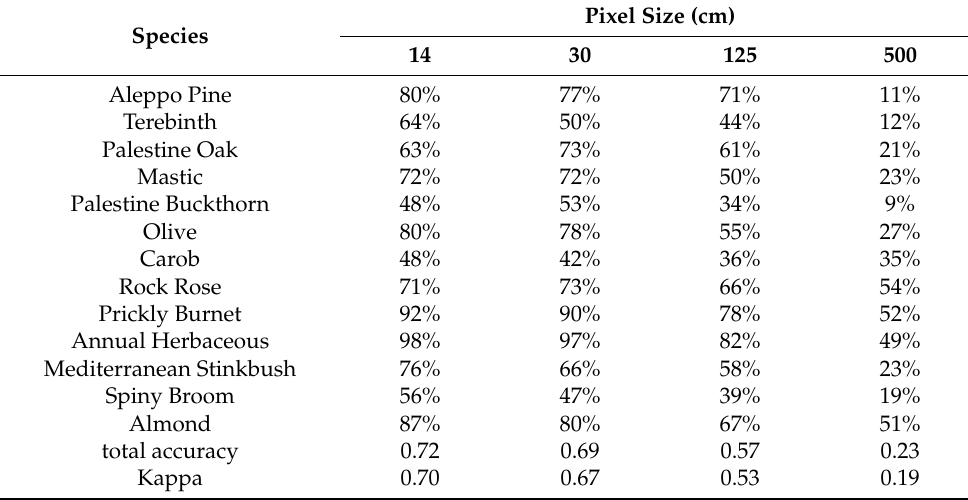
Table 7. An overview of the classification accuracy assessment results (average producer’s accuracies) of the ExG time series, based on the UAV images, after resampling them to 4 different spatial resolutions. Pixel Size Species